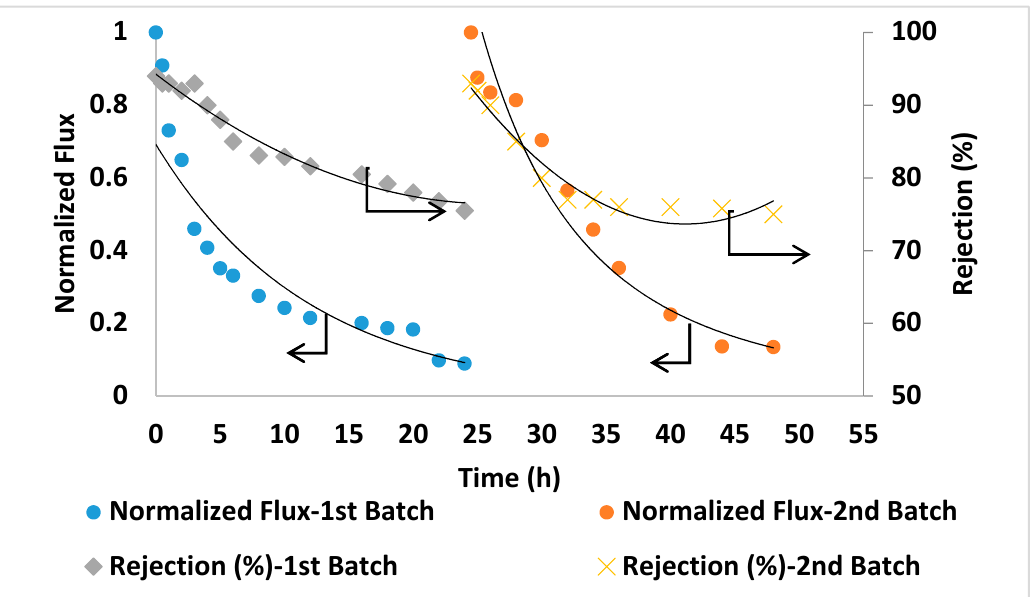
Figure 12. Flux and salt rejection vs time of the commercial membrane (Osmonics). TDS of the feed solution: 45,000 ppm, pH 8.36. Operating pressure: 54 bars.